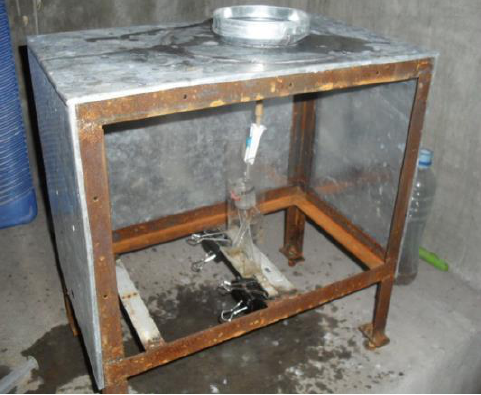
Figure 5. Prototype design of rainfall intensity measuring instrument.